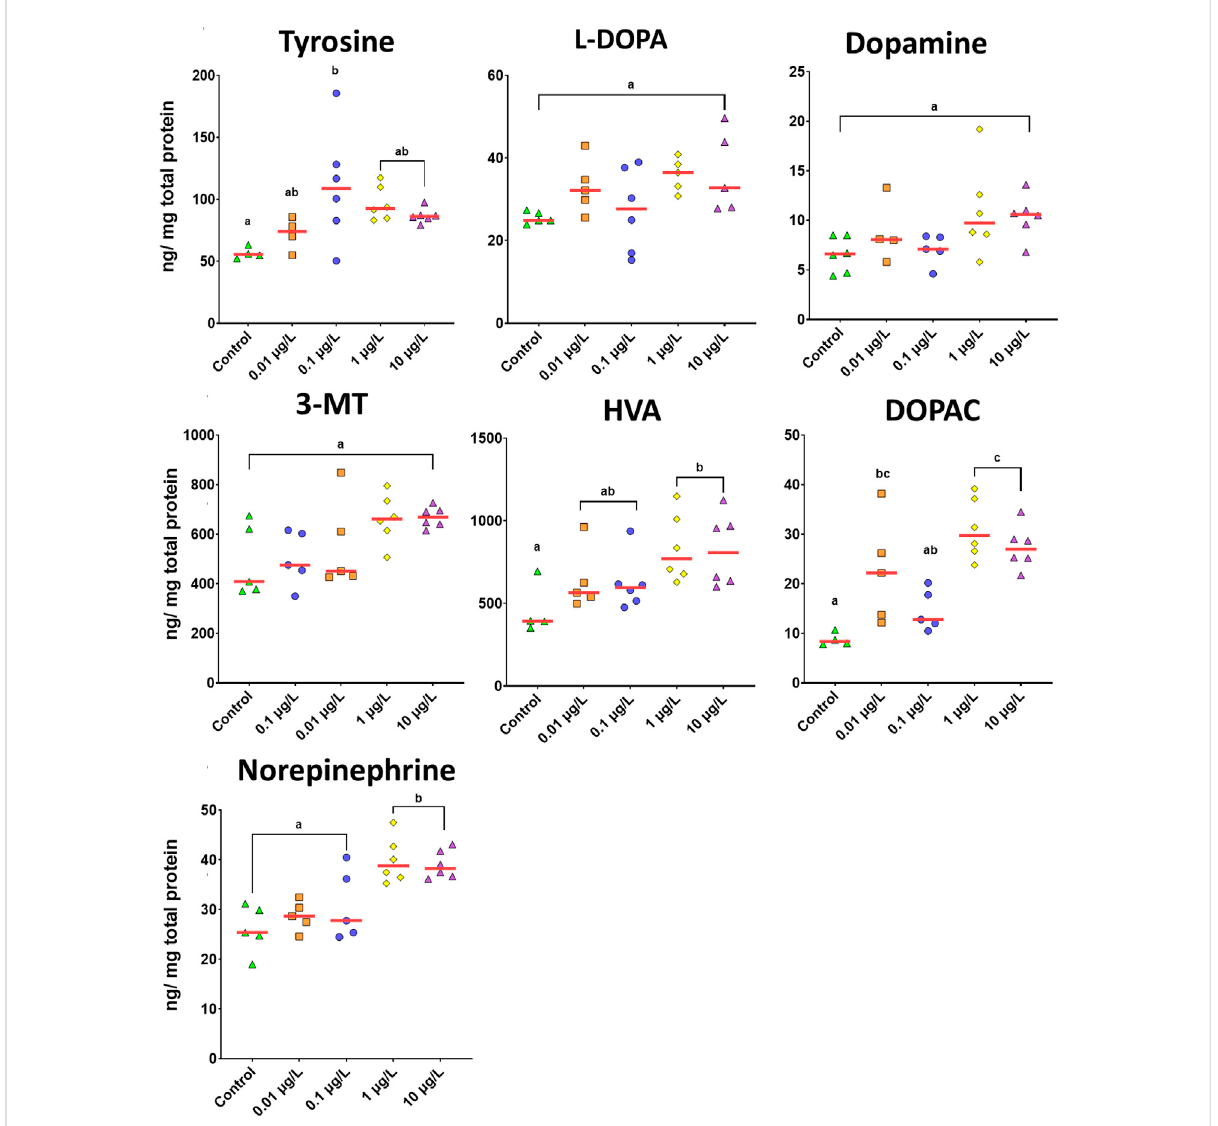
FIGURE 6 Dopaminergic neurotransmitter pro fi les of 8dpf zebra fi sh larvae, following developmental exposure (4hpf to 8dpf) to different concentrations of SER. Results are depicted as scatter plots ( n = 4 – 6) with the median (red line) and represented as ng/mg of protein. Different letters represent different subset groups following Tukey post hoc